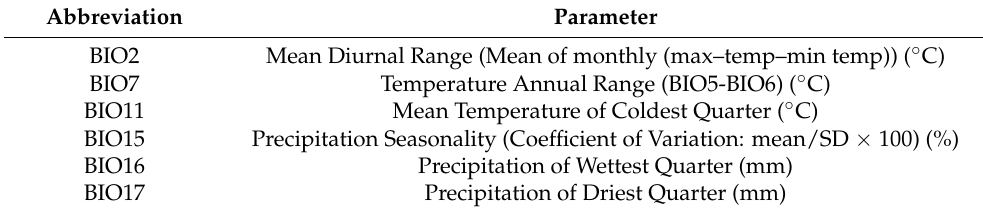
Table 1. Bioclimatic variables used in the